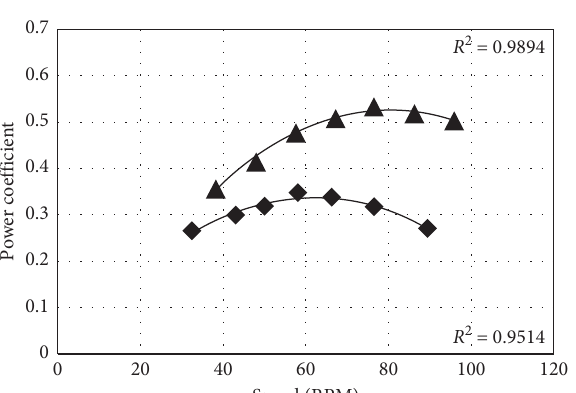
Figure 31: Runner 14 data points.